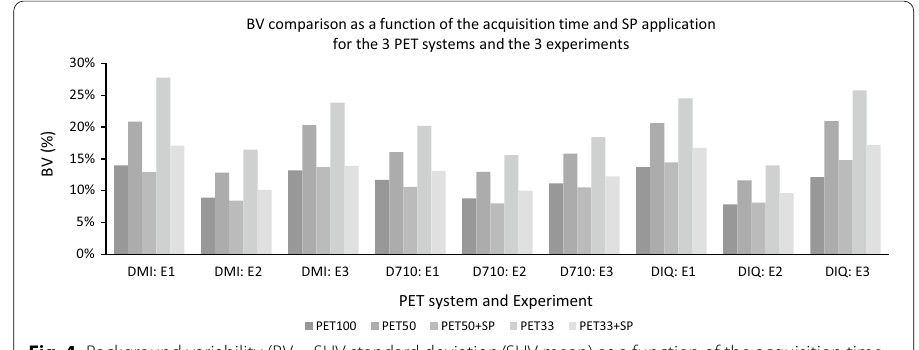
Fig. 4 Background variability (BV SUV standard deviation/SUV mean) as a function of the acquisition time = (PET100, PET50 and PET33) and the application of SubtlePET (PET50 SP and PET33 SP) for the 3 PET + + systems (DMI, D710 and IQ4) and the 3 experiments (E1: IEC phantom and contrast 5:1; E2: IEC phantom and contrast 2:1 and E3: IEC phantom w/microspheres and contrast 5:1)